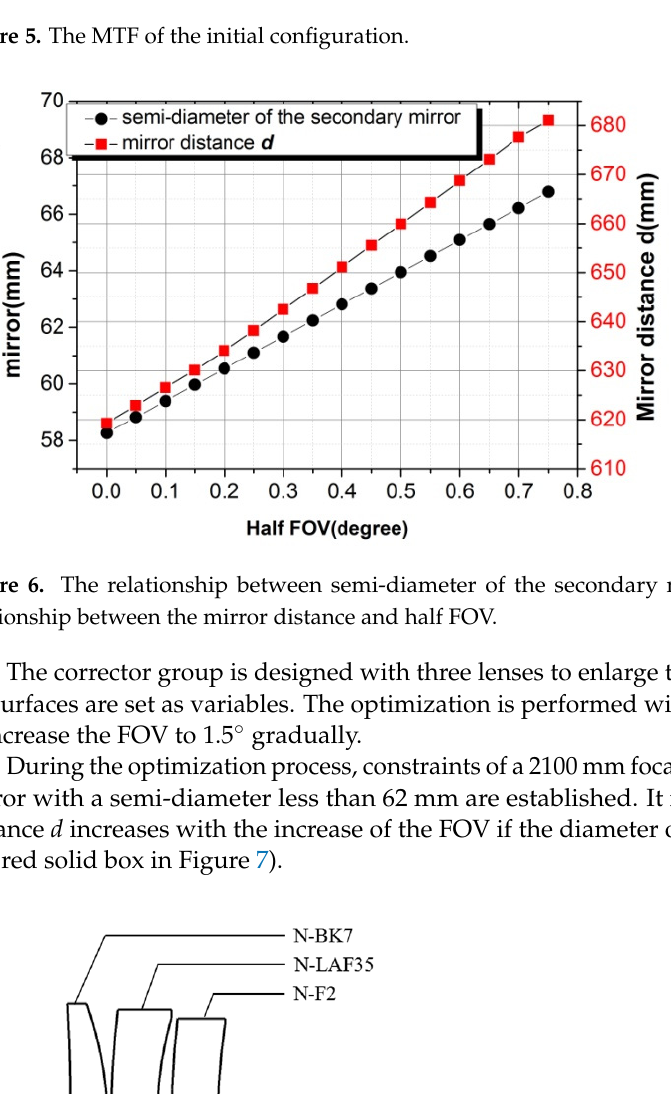
Figure 5. The MTF of the initial configuration.